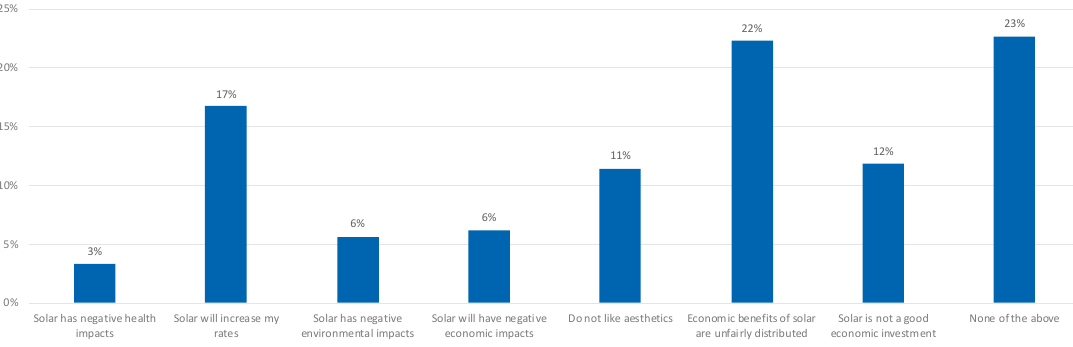
Figure 9. Concerns about Solar Development.